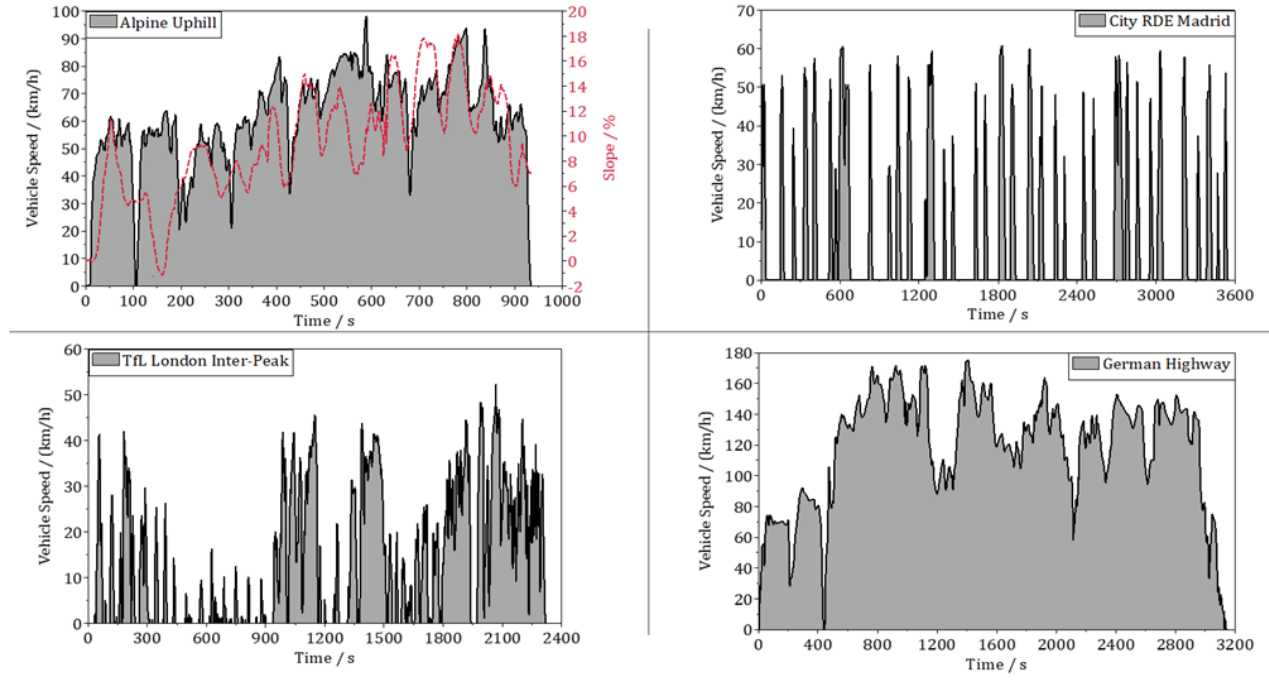
Figure A3. Driving profiles for the Euro 7 scenarios.